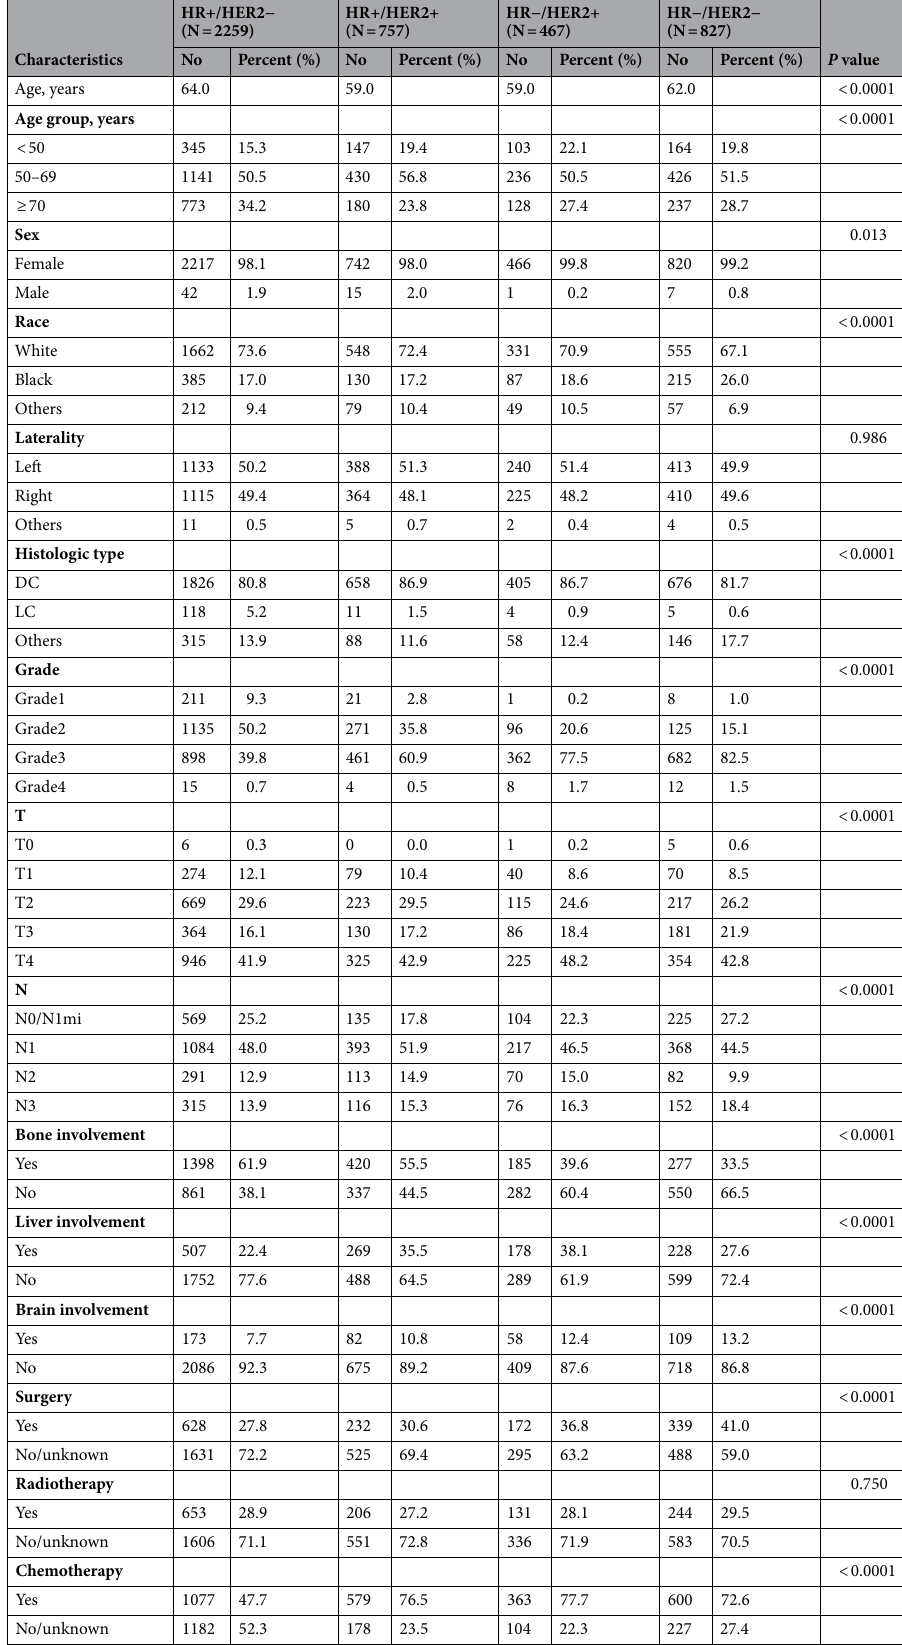
Table 1. Population demographics and baseline characteristics of included patients associated with molecular